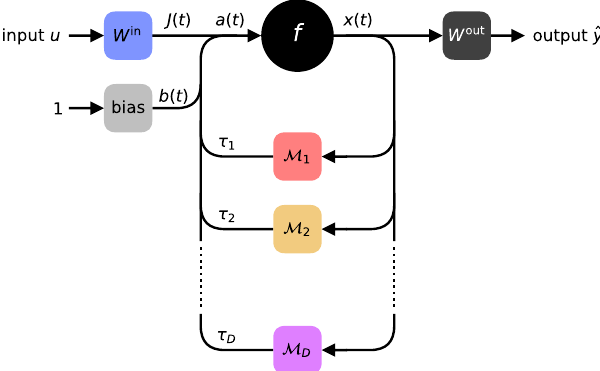
Fig. 1 Scheme of the Fit-DNN setup. A nonlinear element (neuron) with a nonlinear function f is depicted by a black circle. The state of the neuron at time t is x ( t ). The signal a ( t ) is the sum of the data J ( t ), bias b ( t ), and feedback signals. Adjustable elements are indicated by square boxes. The data signal is generated from an input vector u using a matrix W in containing input weights (blue box). The bias signal is generated using bias coef fi cients (light gray box). Each feedback loop implements a delay τ d and a temporal modulation M d ð t Þ (color boxes) to generate the feedback signals. Finally, the output is obtained from the signal x ( t ) using a matrix W out of output weights (dark gray